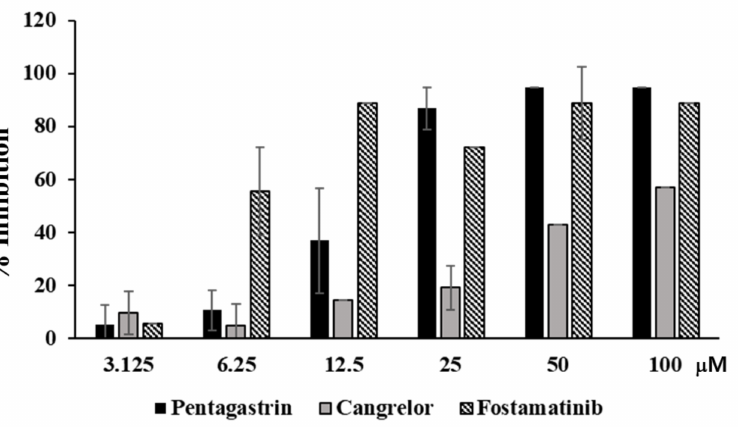
Figure 7. Cangrelor and fostamatinib inhibits Asfv PolX activity. Cangrelor and fostamatinib was mixed with 100 ng of Asfv PolX for 10 min and polymerase activities were measured as described in Materials and